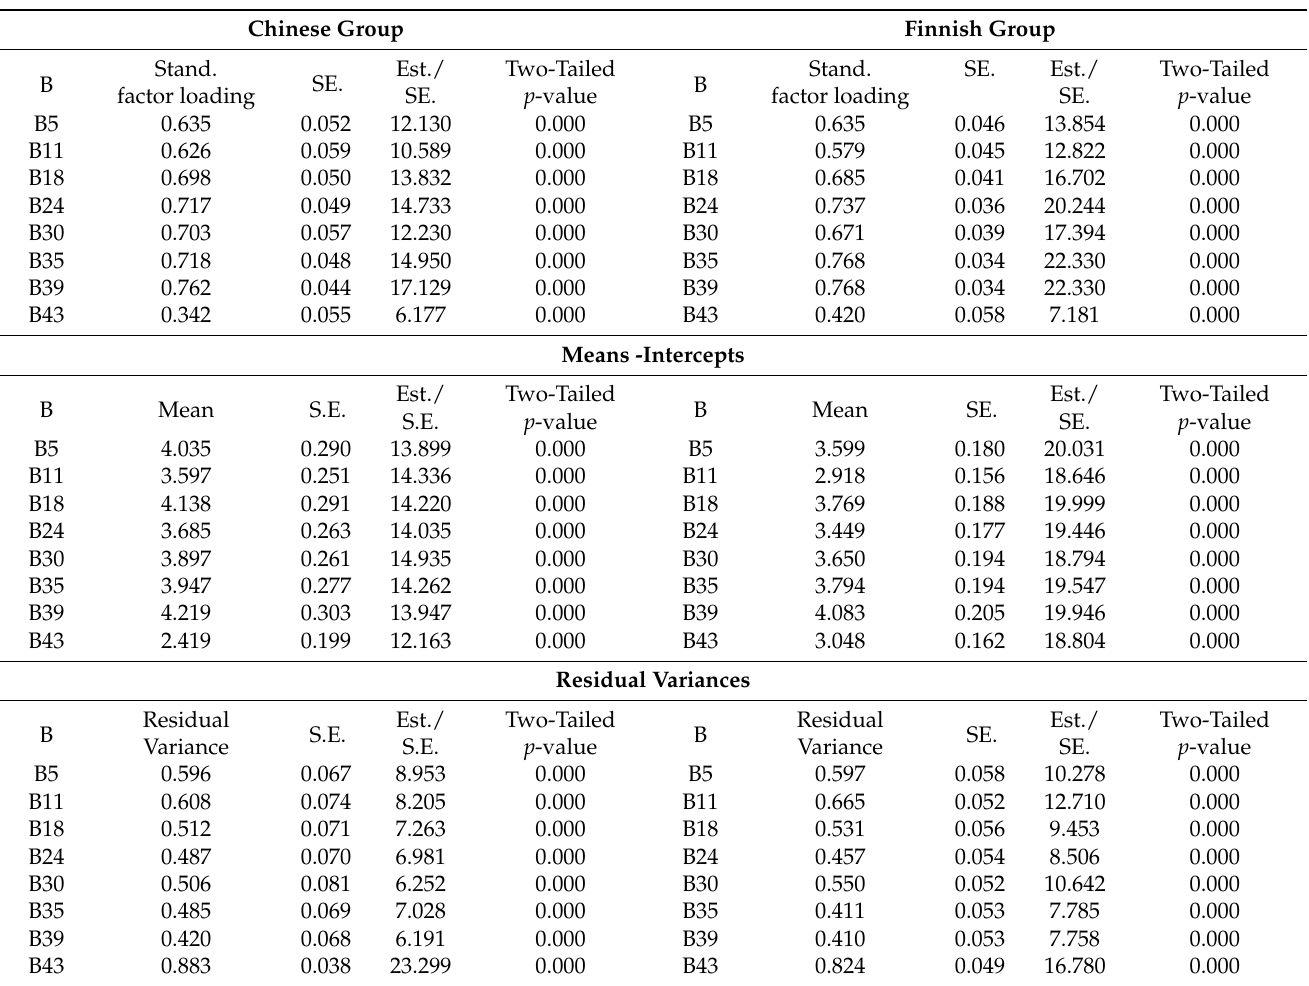
Table 4. Benefit latent variable—weak factorial